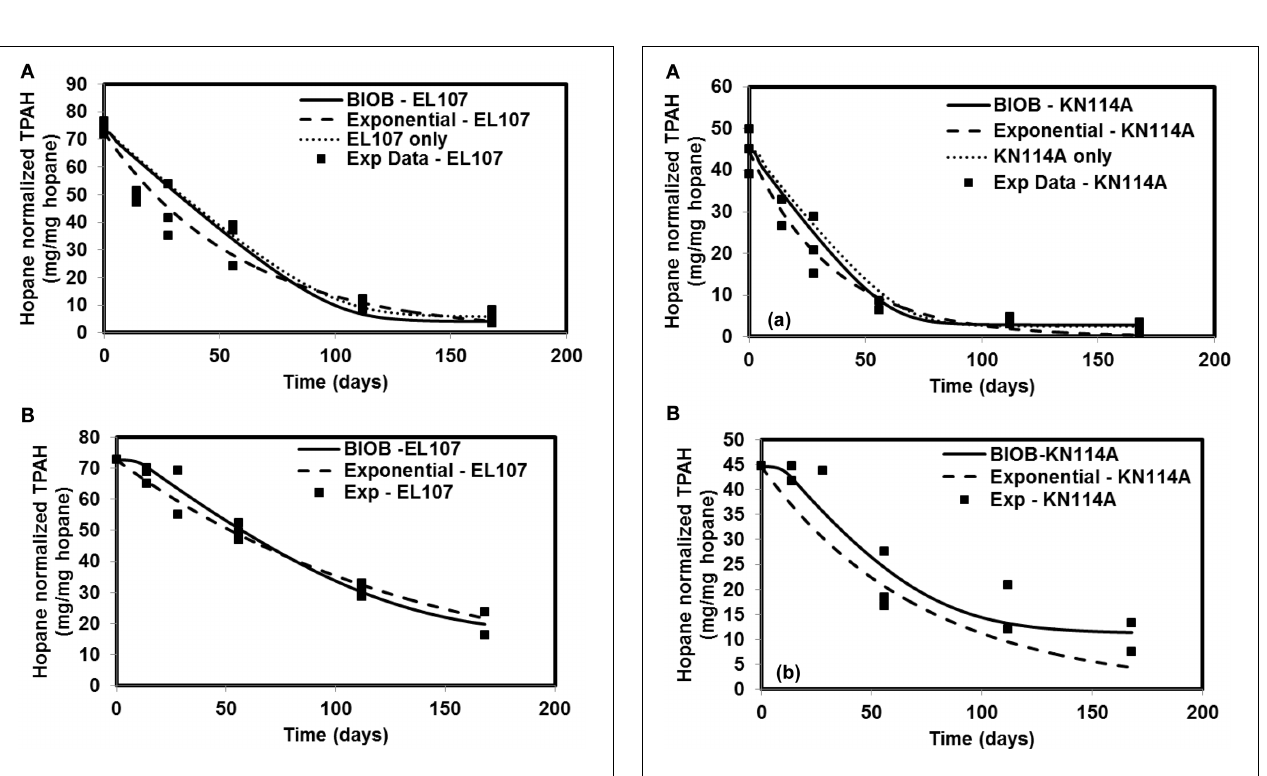
FIGURE 2 | Comparison of model results and the experimental results for Knight Island (KN114A) (A) Nutrient amended experiments (B) Natural